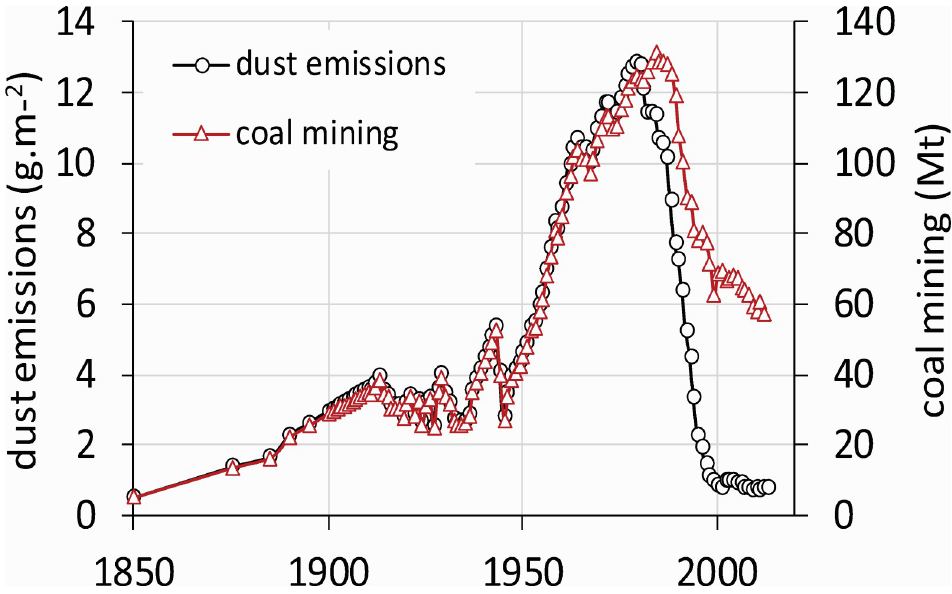
Fig 2. Coal mining and dust emissions in the Czech Republic between